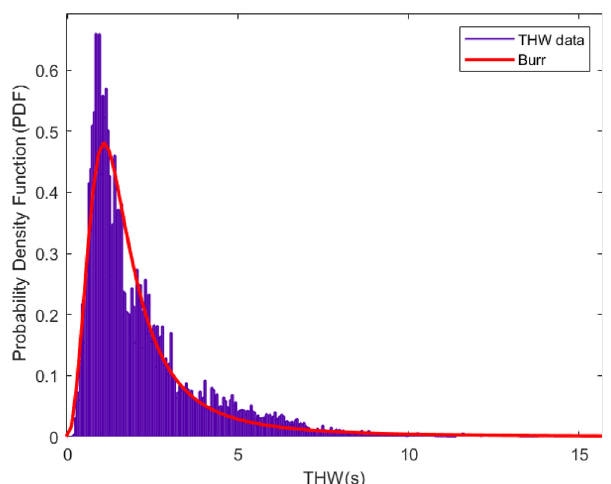
Figure 5 Result of the distribution model fi